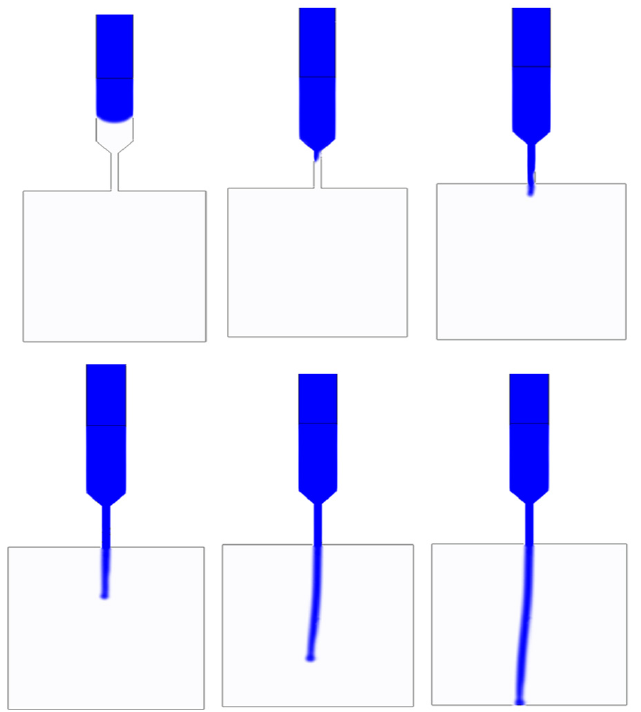
Figure 12. Time-lapse of the volume fraction of the melted PLA filament flowing through the Figure 12. Time ‐ lapse of the volume fraction of the melted PLA filament flowing through the nozzle.